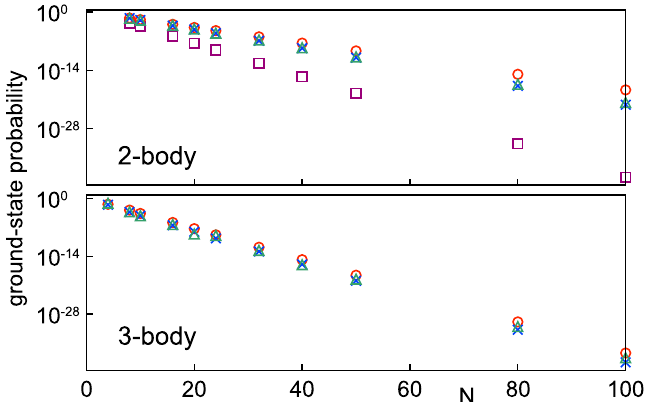
Figure 6: Size dependence of the ground-state probability for ˆ H (top) and for ˆ H (bottom). We take δ = 2.0. Legend is the same as in Fig. 3 − body